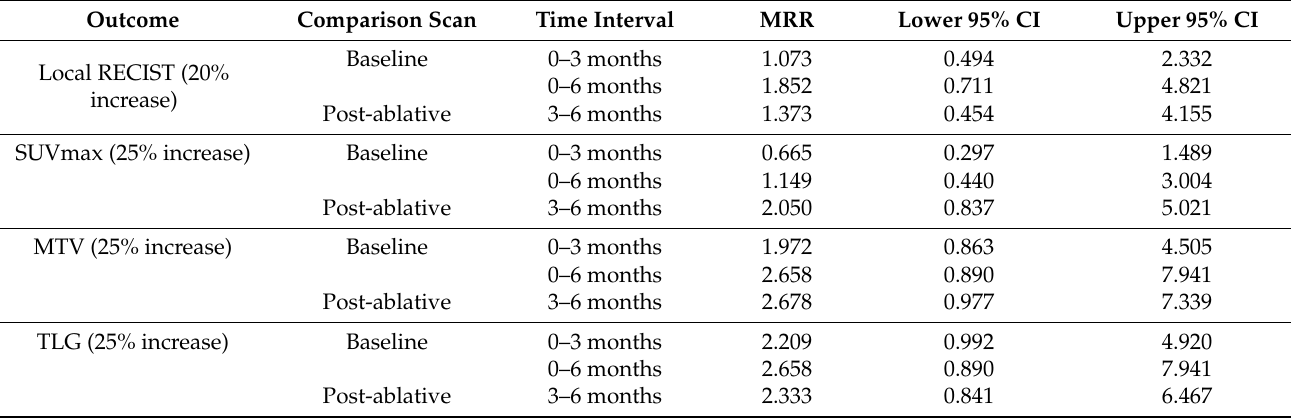
Table 3. Univariate regression analysis of categorical lesion-level outcomes.